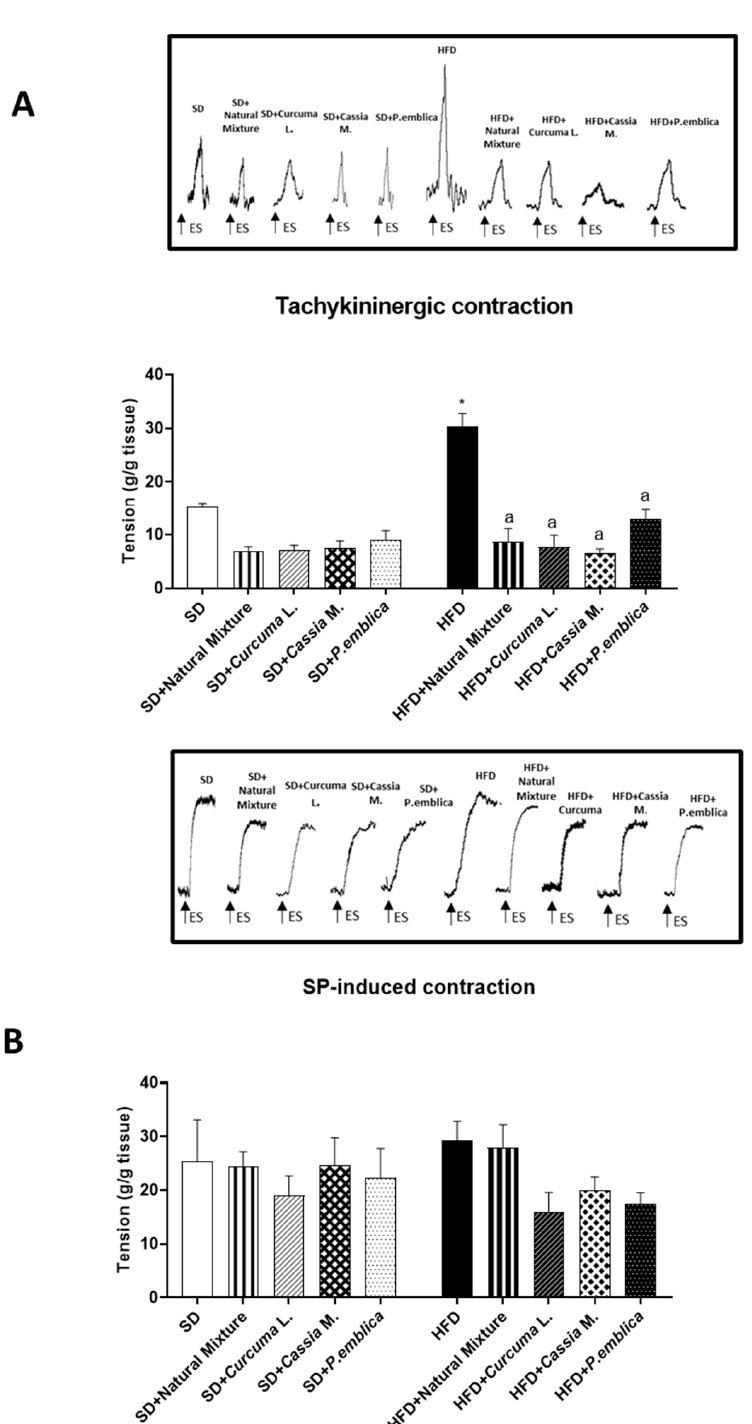
Figure 5. Effect of natural mixture on in vitro colonic contractile responses. ( A ) Tachykininergic contractions mediated by NK1 of colonic longitudinal smooth muscle preparations taken from HFD- and SD-fed mice treated with natural mixture, Curcuma L., Cassia M. and P. emblica . ( B ) Contractions elicited by exogenous SP (1 µ M) in colonic preparations taken from mice treated with natural mixture, Curcuma L., Cassia M. and P. emblica . Each column shows the mean ± S.E.M. ( n = 6). One-way ANOVA and Tukey post hoc test results are as follows: *— p < 0.05 for significant difference vs. the SD group; a — p < 0.05 for significant difference vs. the HFD group. Abbreviations: HFD— high fat diet; SD—standard diet; SP—substance P.